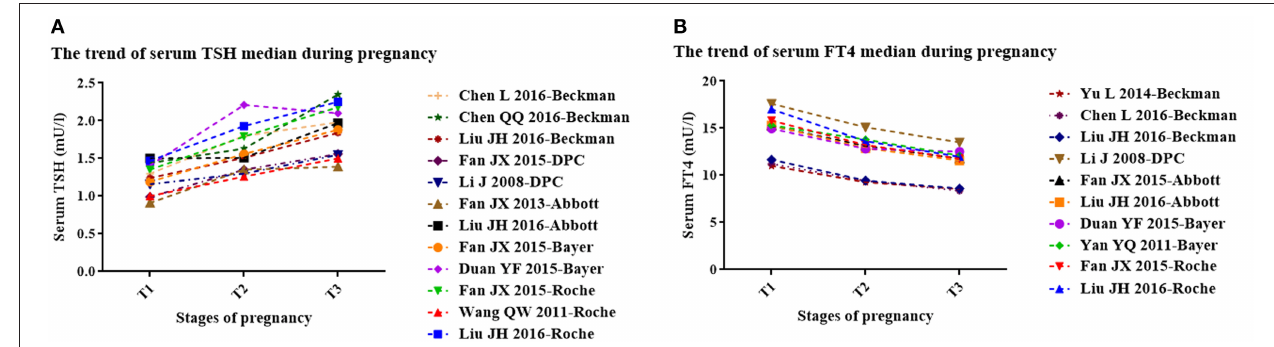
FIGURE 2 | The trend of serum TSH (A) and FT4 (B) median during pregnancy. T1, the first trimester of pregnancy; T2, the second trimester of pregnancy; T3, the third trimester of pregnancy. (A) The trend of median gestational serum TSH in each study (3 studies with Roche kits; 2 studies with Bayer kits; 2 studies with Abbott kits; 2 studies with DPC kits; 3 studies with Beckman kits). (B) The trend of gestational serum FT4 median in each study (2 studies with Roche kits; 2 studies with Bayer kits; 2 studies with Abbott kits; 1 study with DPC kits; 3 studies with Beckman